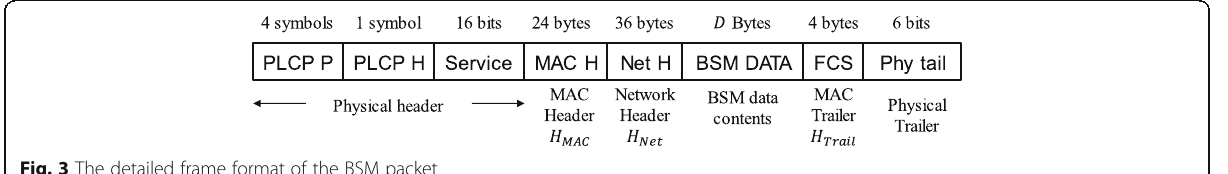
Fig. 3 The detailed frame format of the BSM